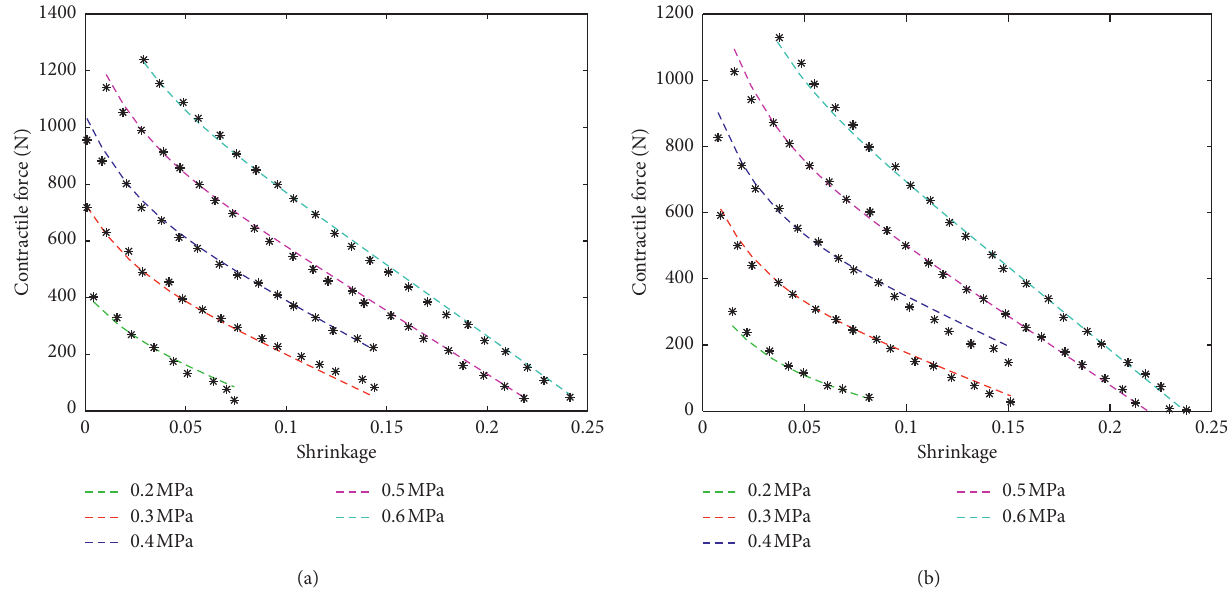
Figure 10: Comparison of the static mathematical model with experimental data when PAM shrinking and stretching.